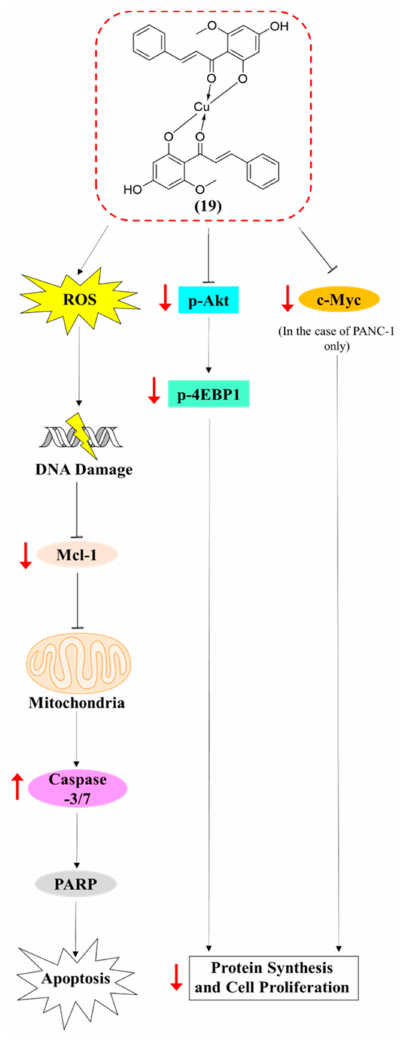
Figure 13. Schematic representation of the proposed signalling pathways perturbed by 19 in MDA- MB-468 and PANC-1